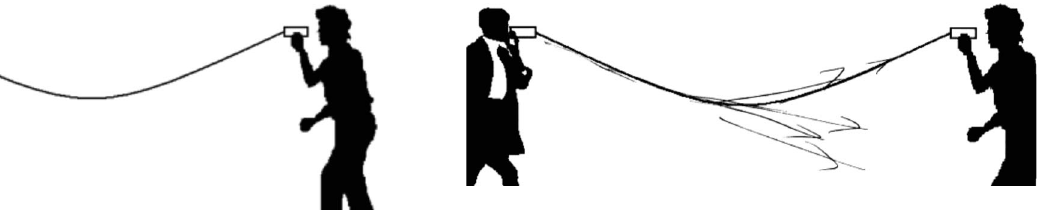
FIG. 11. Student’s drawing over provided template to